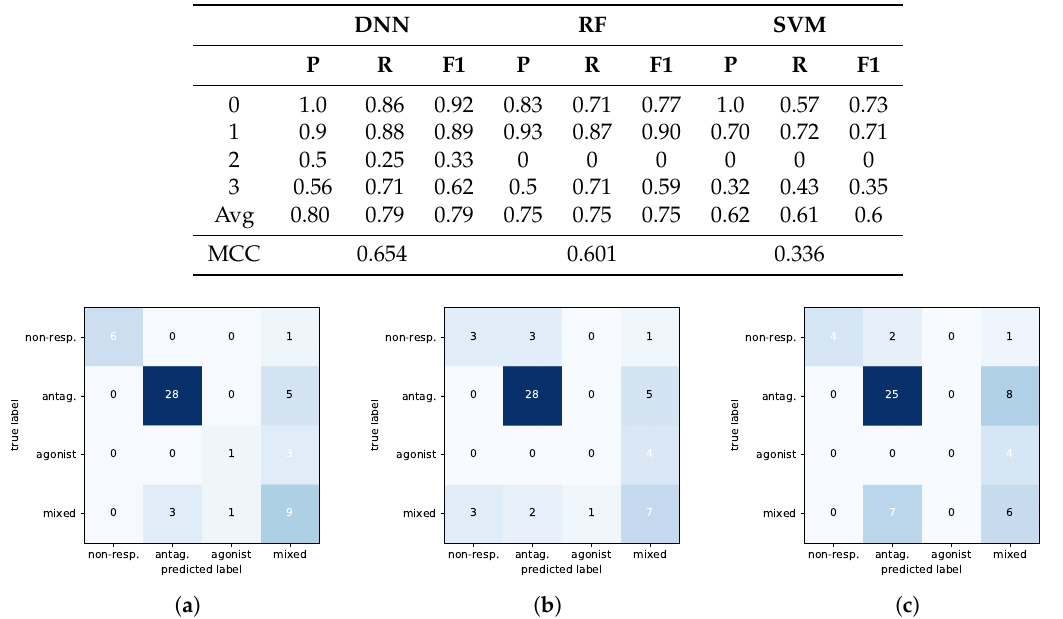
Figure 4. Confusion matrices of three methods on test set. Predicted classes are along the x-axis with the true class on the y-axis. ( a ) DNN. ( b ) RF. ( c )